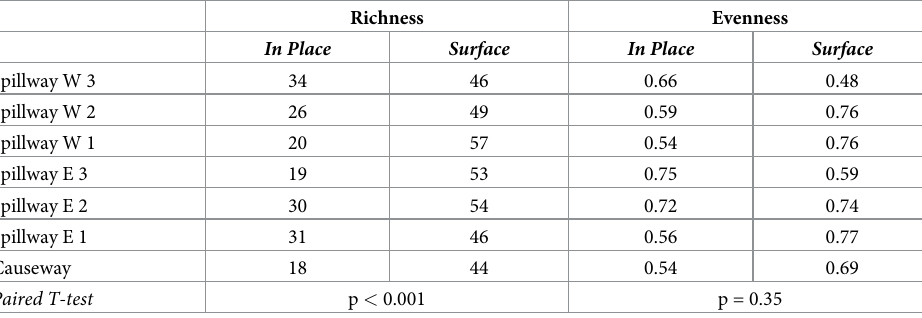
Table 2. Diversity metrics. Richness and evenness for the brachiopod and mollusk